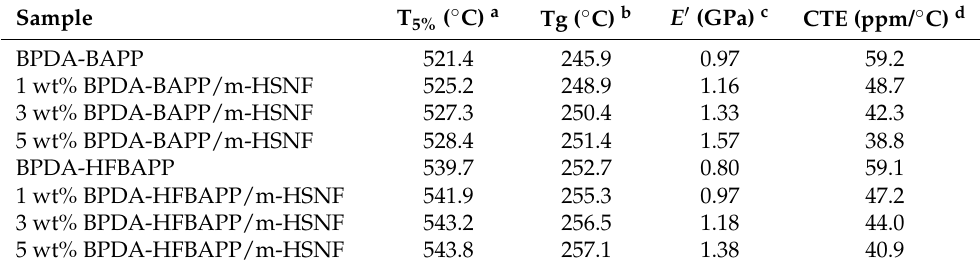
Table 2. Thermal and mechanical properties of polyimide/m-HSNF composites.